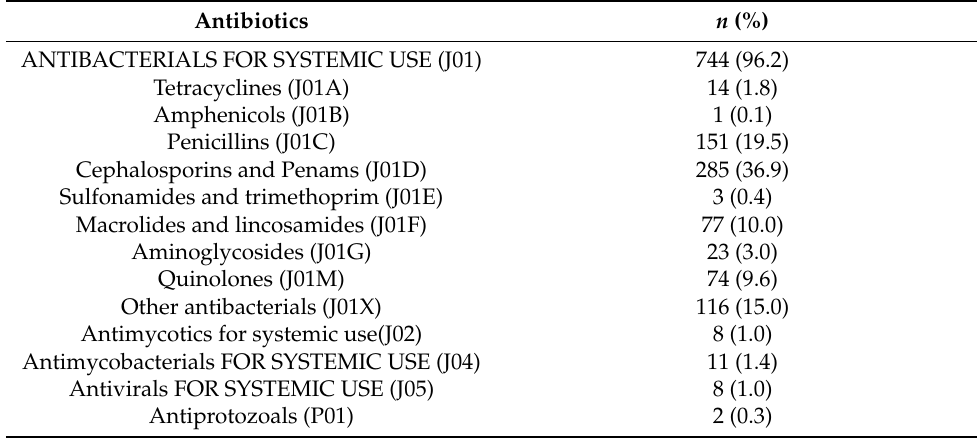
Table 2. Use the prevalence of main antibiotics